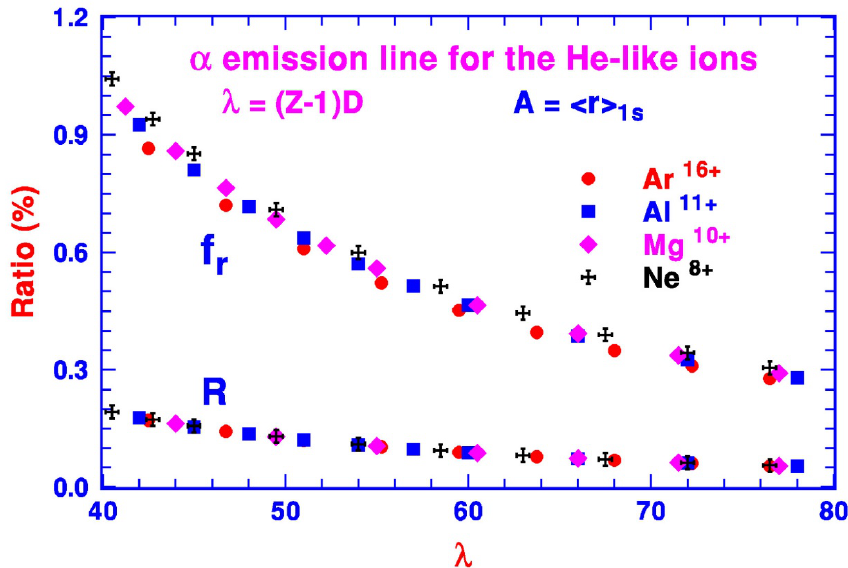
Figure 5. The percentage change of the redshifts R and the corresponding f r of the oscillator strengths for the 1 s 2 1 S → 1 s 2 p 1 P transition of the He-like ions as a function of λ